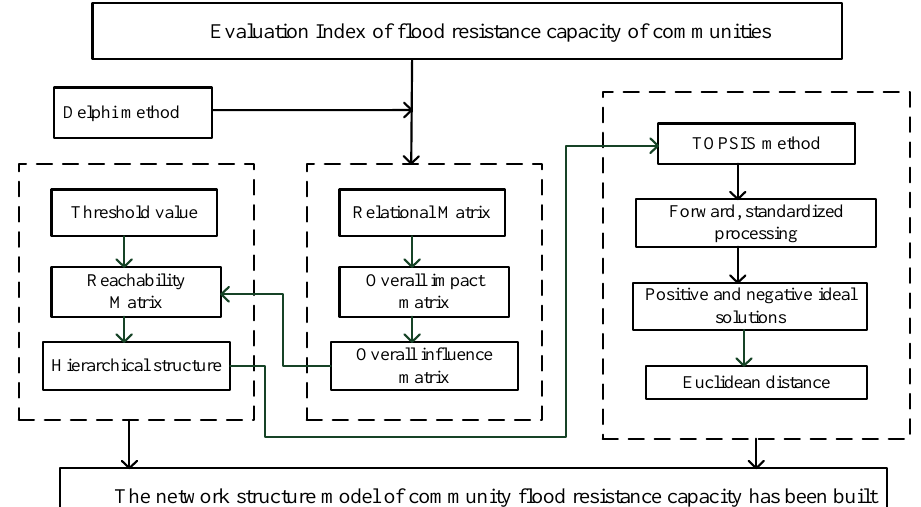
Figure 1. Network structure model of the flood resistance capacity of communities.